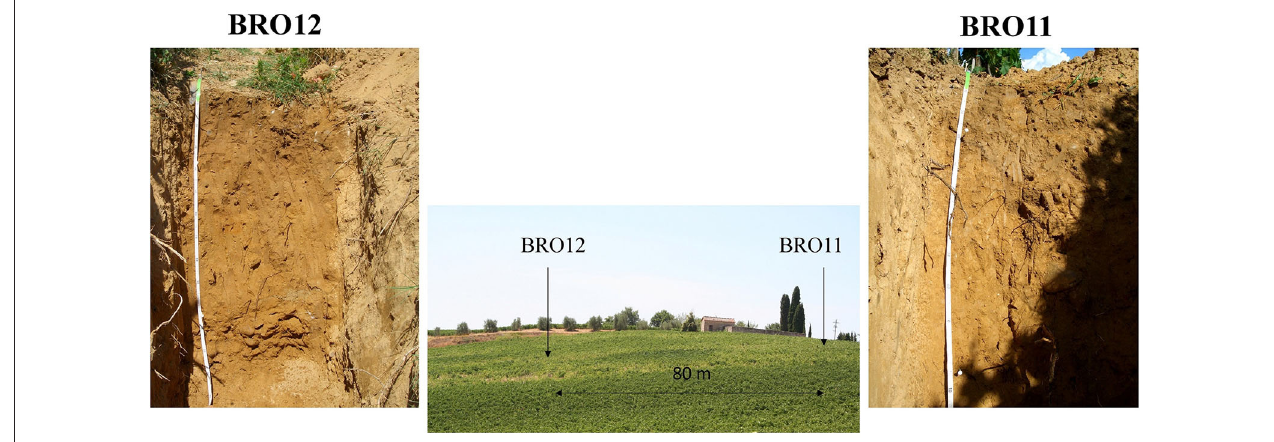
FIGURE 1 | Pictures of the studied vineyard (from North to Southward) and soil profiles of BRO11 and BRO12 plots. + 10%) and coarse fragments (about + 10%), as well as slightly lower organic carbon (about − 4 g · kg − 1 ) and available water capacity (AWC, − 10 mm · m − 1